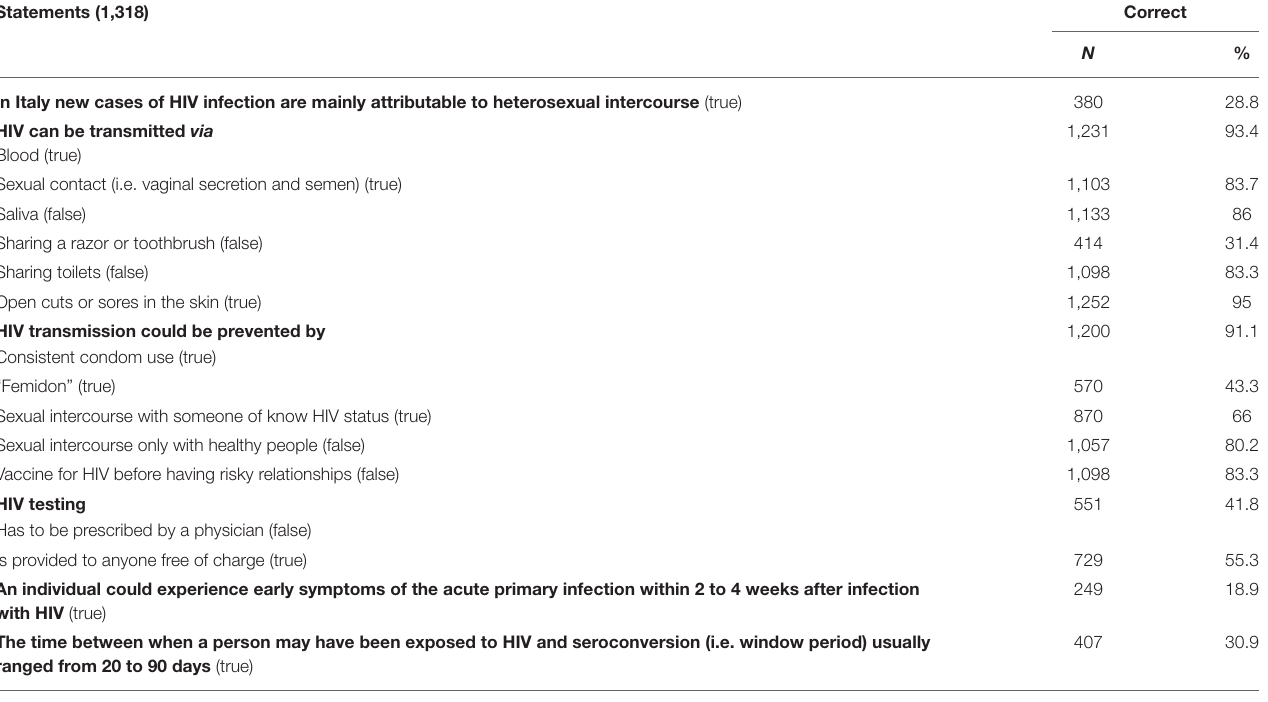
TABLE 1 | Respondents’ knowledge related to HIV